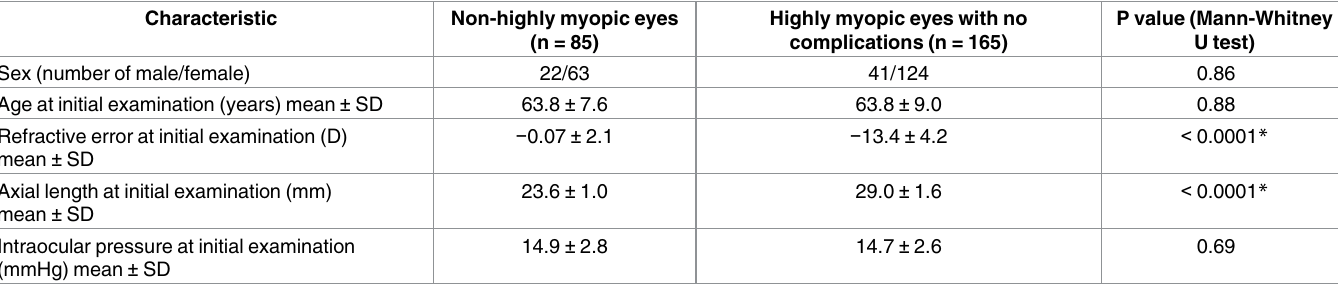
Table 2. Comparison of clinical characteristics between the non-highly myopic eyes and the highly myopic eyes with no complications.